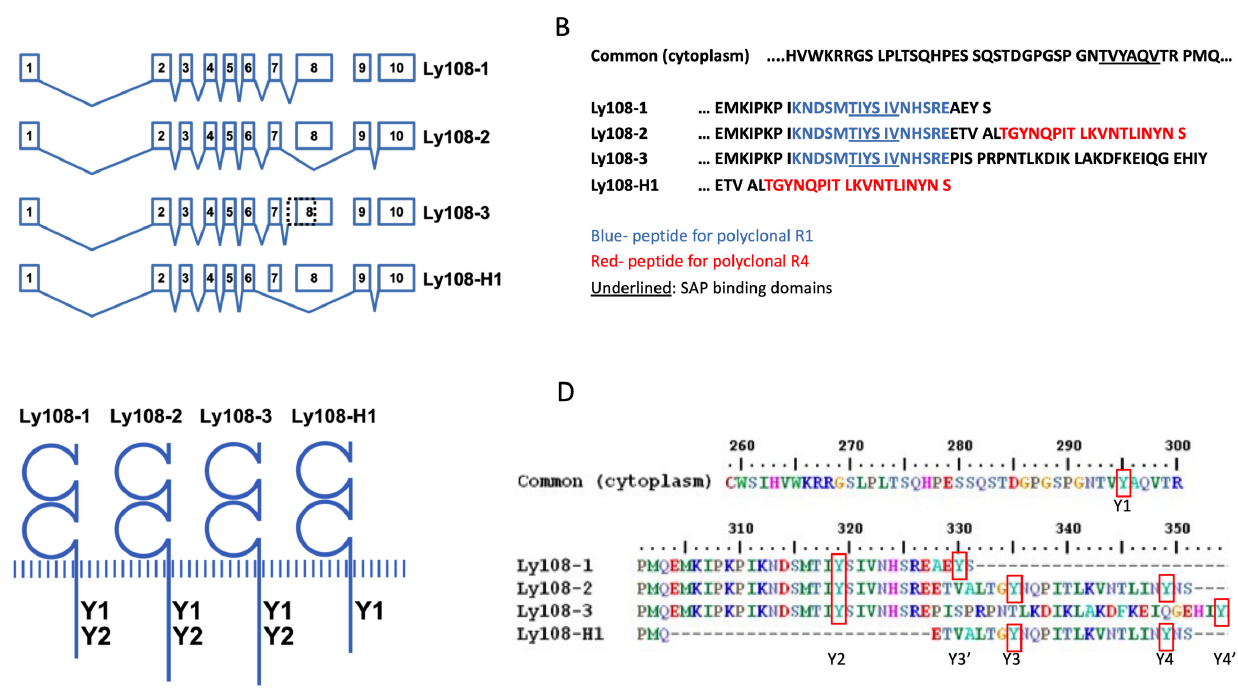
Figure 1. Schematic comparison of Ly108 isoforms. ( A ) Exon-intron organization of murine Ly108 ( SLAMF6 ) with alignment of Ly108 isoforms. The Ly108-2 isoform is generated by skipping exon 8 with transcription of exon 9 and 10. Ly108-3 is the result of an alternative splice acceptor site in intron 7 resulting in a frame shift. Ly108-H1 is the result of skipping exon 7 and 8. ( B ) Alignment of amino acid sequences from the cytoplasmic domains of Ly108 showing SAP binding sites (underlined) and the sequences used to generate polyclonal antibodies R1 (blue) and R4 (red). ( C ) Illustration of Ly108 isoforms with the position of the tyrosines corresponding to ITSMs (SAP/EAT-2 binding sites) indicated. ( D ) Experimental ITSMs and plausible phosphorylation sites in the different Ly108 variants. Tyrosine residue annotation (red squares) using Ly108-2 as reference appear in position 295, 319, 335, and 349 (Y1–Y4). Other tyrosines shown are Y3 (cid:48) in Ly108-1 and Y4 (cid:48) in